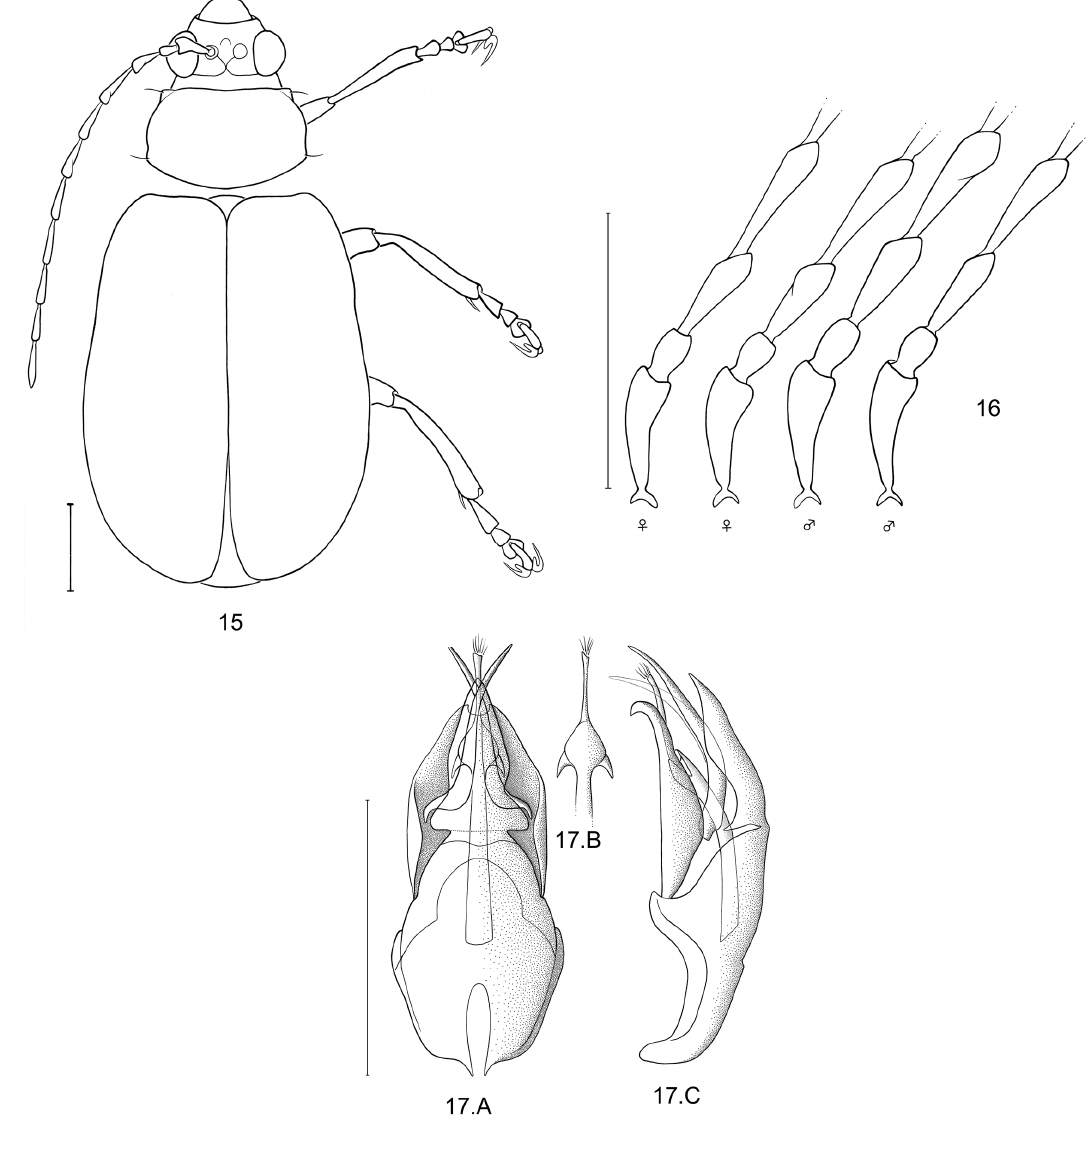
Figs 15-17. O. anningae sp. nov. 15 . Habitus, semi-schematic dorsal view. 16 . Basal four antennomeres of 2 ♂♂ and 2 ♀♀. 17 . Median lobe. A . Dorsal. B . Detail: apex of endophallus. C . Lateral. Scale bars: 1